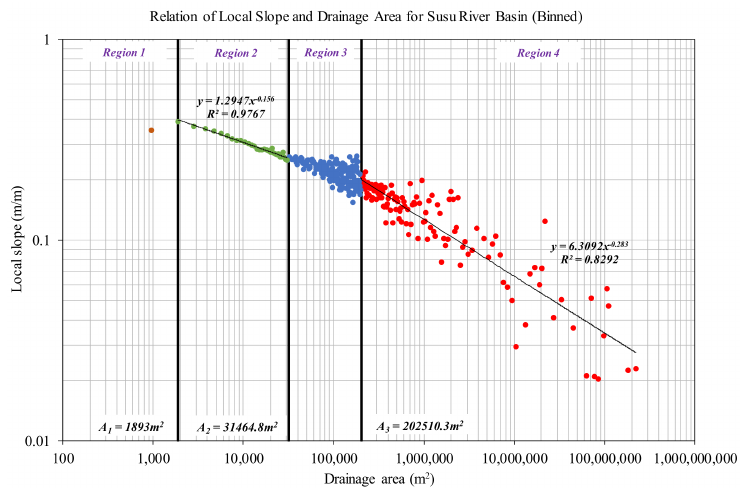
Figure 3. Relationship between local slope and drainage area for the Susu River Basin